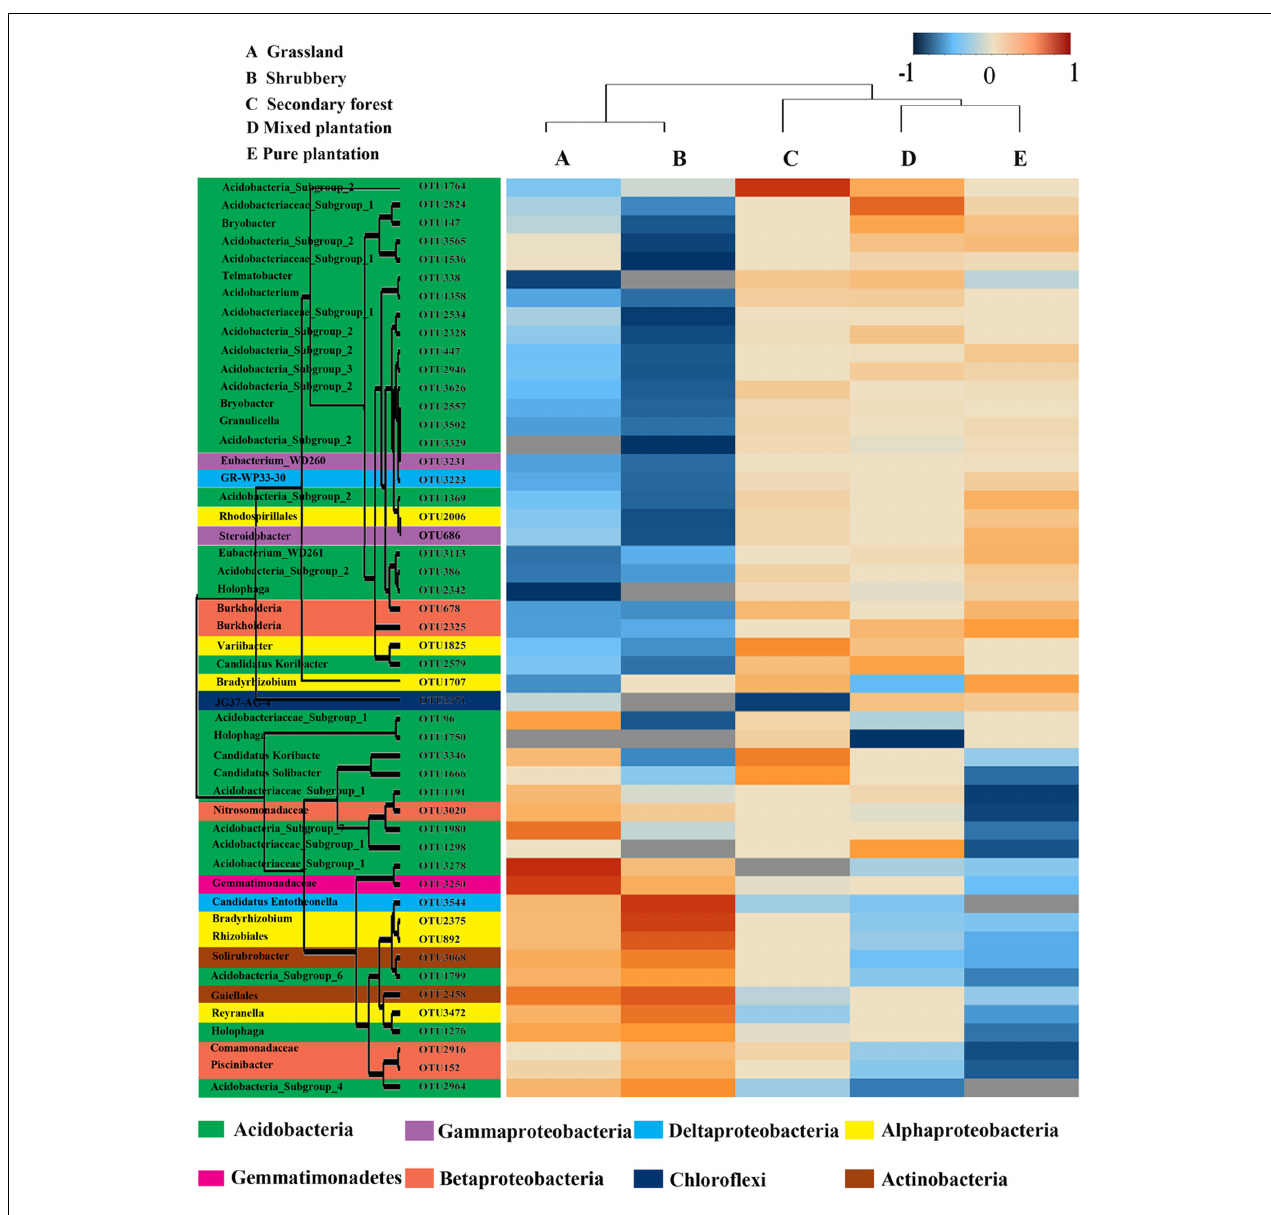
FIGURE 3 | A heatmap diagram of the dominant 50 OTUs under five vegetation